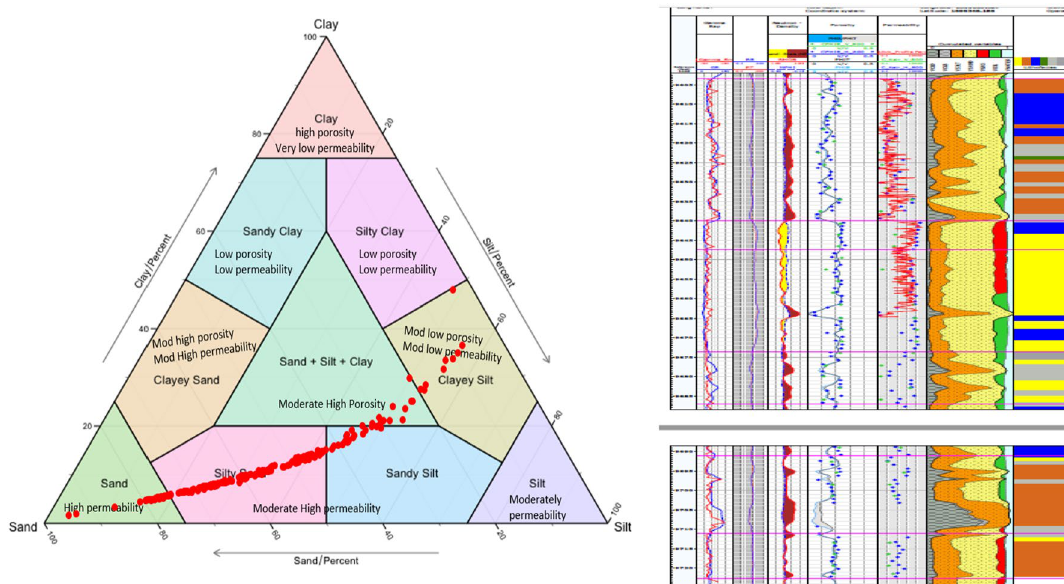
Fig. 11 Ternary diagram for the cored interval in the study well